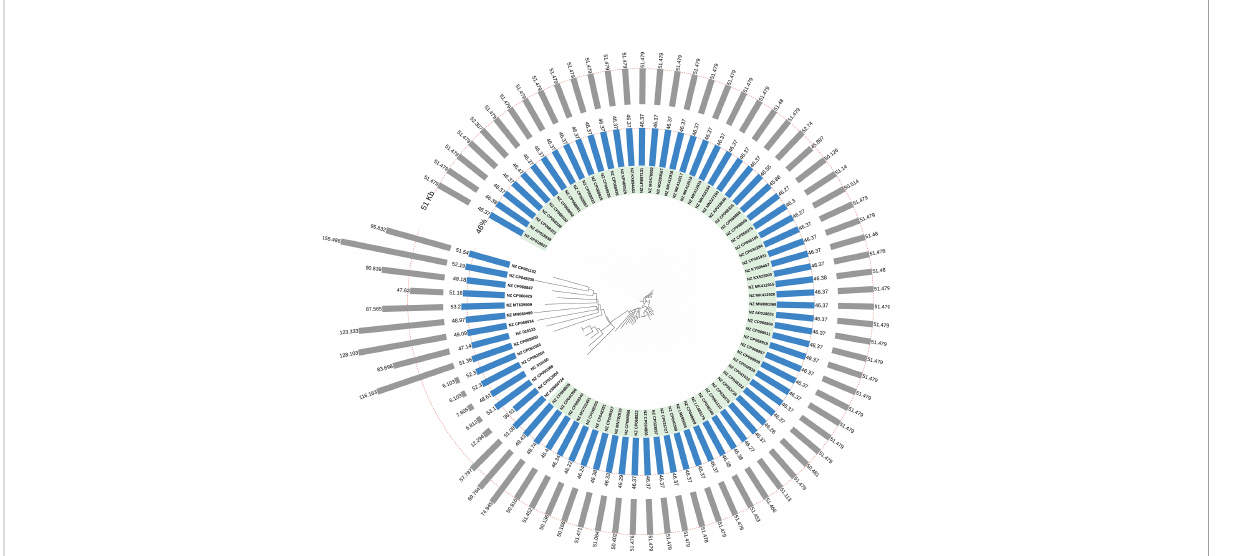
FIGURE 4 Distribution of lengths and GC contents of the 81 bla OXA-181 -harboring plasmids in Enterobacterales . The 66 bla OXA-181 -harboring IncX3 plasmids were highlighted in light green. The outermost grey bars denote the lengths of the bla OXA-181 -harboring plasmids. The bars in light blue denote the GC content of the 81 bla OXA-181 -harboring